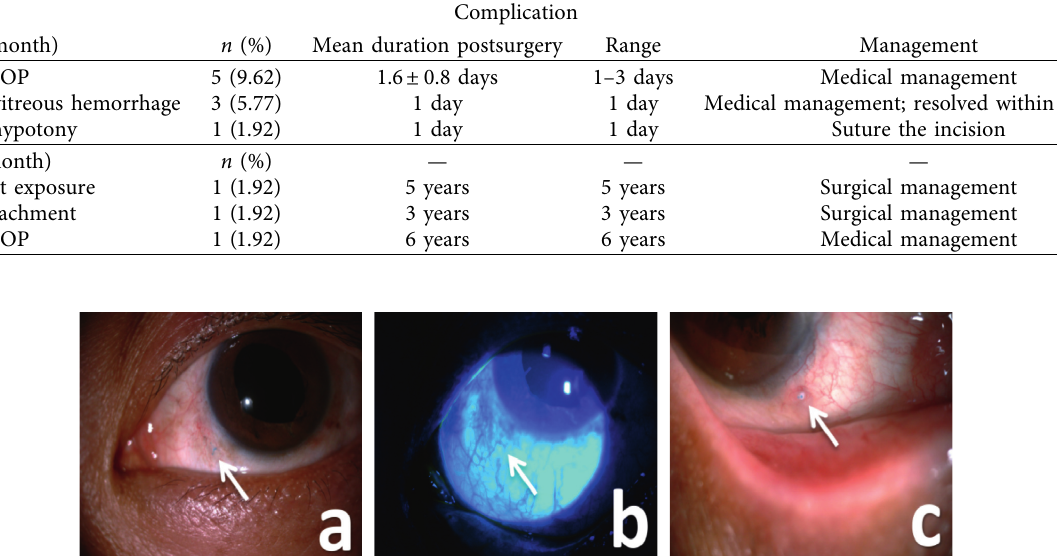
Figure 2: Scattergram of BCVA in 52 eyes that underwent SSF-IOL implantation. BCVA is represented in logMAR values. BCVA: best- Table 2: Distribution and management of postoperative complications in eyes undergoing SSF-IOL.